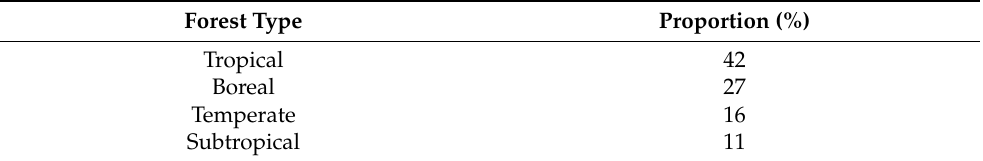
Table 1. Proportion of forest area by climatic domain in the year 2020 (adapted from https://www.cepf-eu.org/news/two-important-reports-published-worlds-forests, accessed on 22